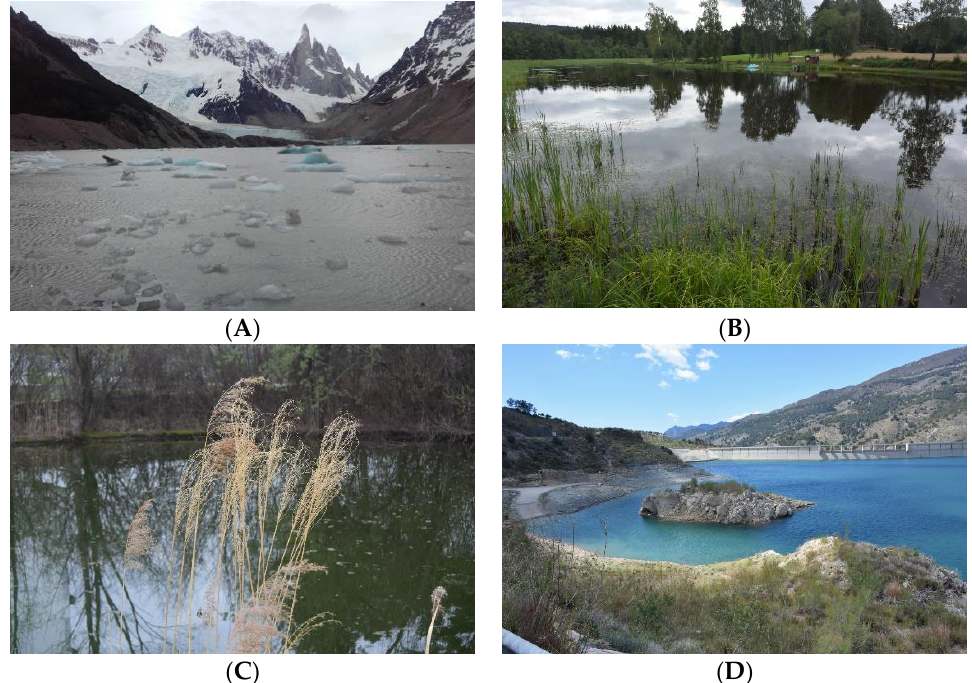
Figure 2. Example sampling locations of different climates: ( A ) Los Glaciares Laguna Torre ARG; ( B ) Heinrichs AUT (isolate: Chlorogloeopsis fritschii ; ( C ) Tulln IFA-Teich AUT (isolate: Synechocystis sp.); and ( D ) Presa de Beninar ESP (isolate: Crocosphaera sp.). A total of 71 samples were taken from 25 locations (details in Table 1).